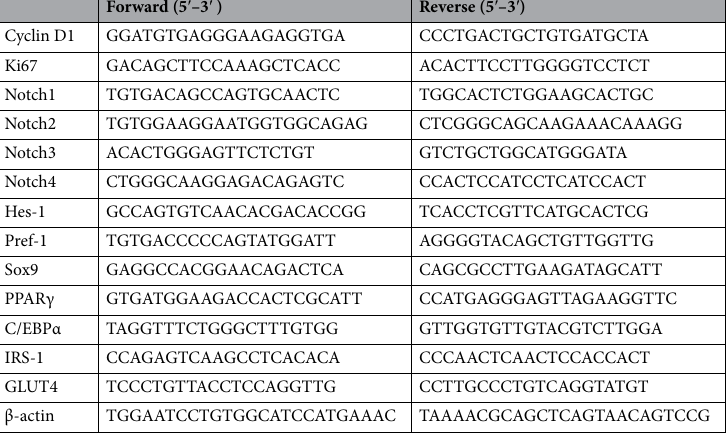
Table 1. Sequences of primers used for